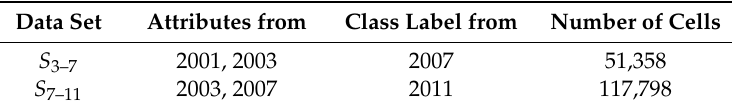
Figure 2. Land-use changes for the following time intervals: ( a ) 2001–2003, ( b ) 2003–2007, and ( c ) 2007–2011. Table 2. Description of data sets used in the experiments. Table 2. Description of data sets used in the